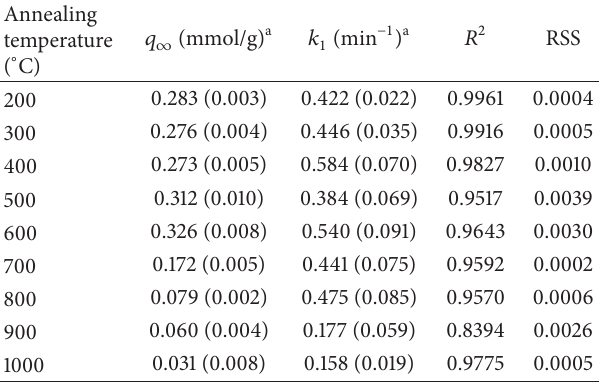
Table 2: Parameters of the pseudo-first-order kinetic equation for annealed at different the sorption of AO7 on CeO 2